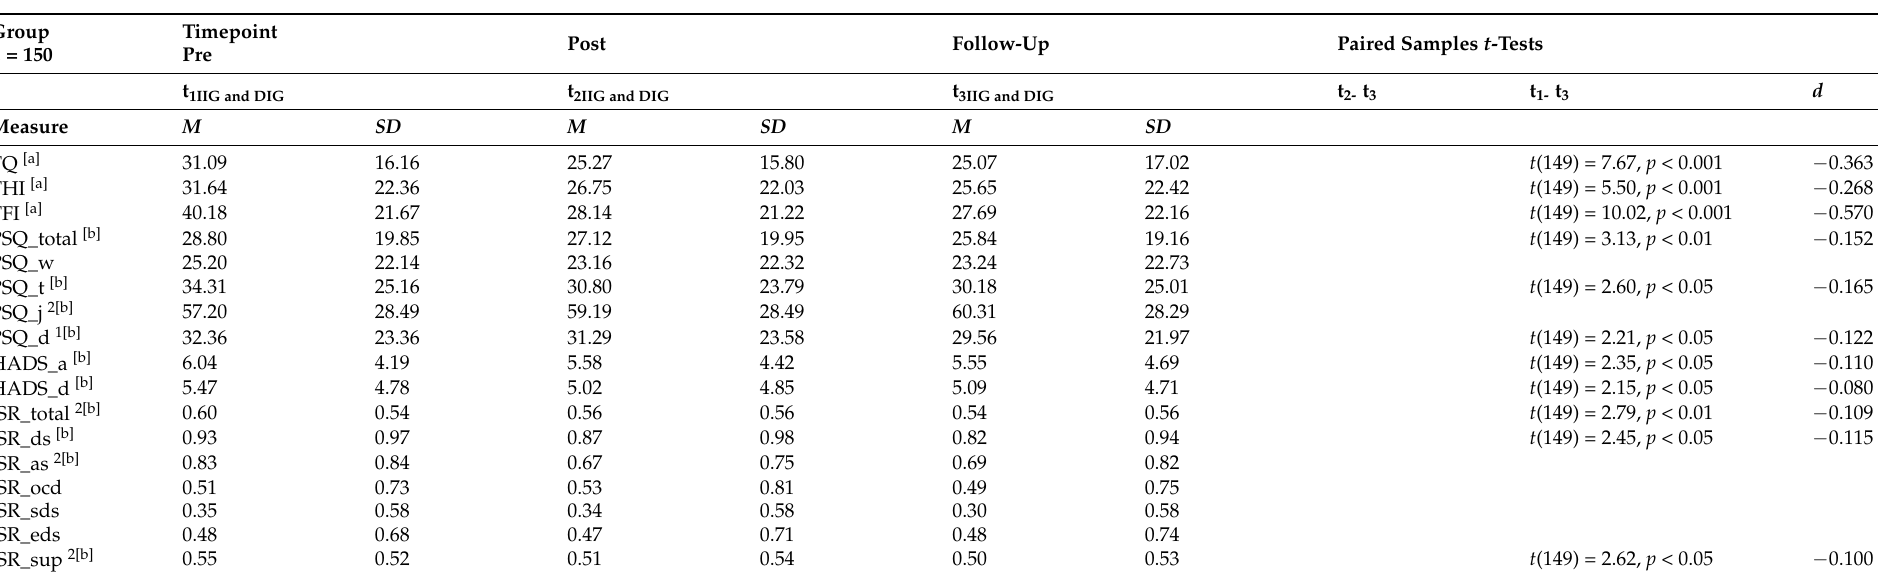
Table 3. Means, standard deviations, and significant pairwise comparisons investigating [a] the stability of identified treatment effects ( t 2- t 3 ) and [b] exploratory uncontrolled pre- to follow-up changes in the pooled total sample ( t 1- t 3